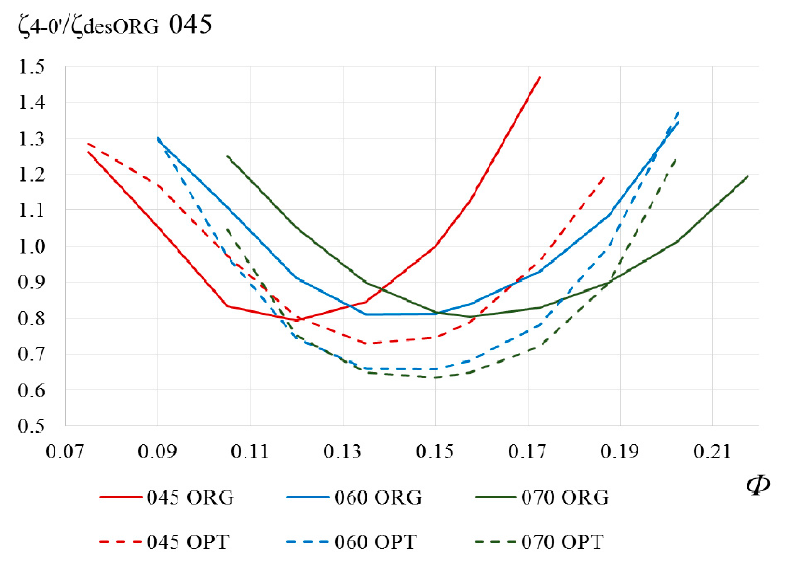
Ф = 0.15 and dif- des